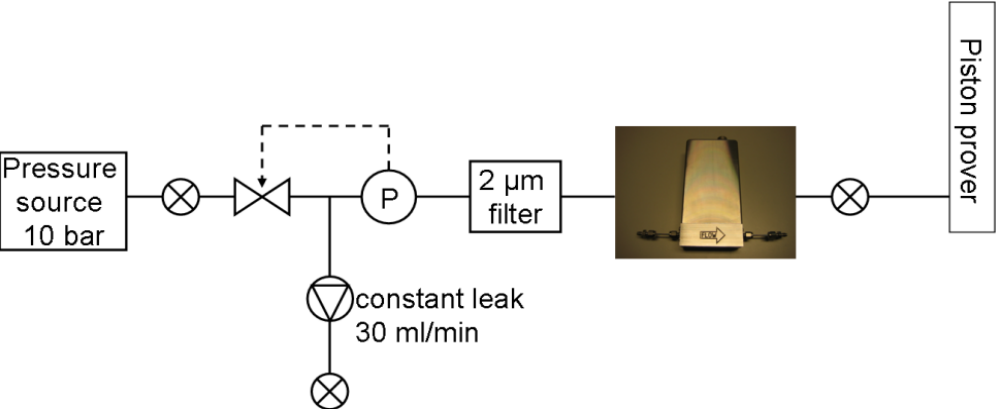
Figure 6. Schematic overview of the setup used for the air mass flow measurements. Air was pressurized at 10 bara. Pressure meter P controls the pressure before the Coriolis mass flow meter. A constant leak of 30 mL/min is necessary for the valve to operate reliably. The filter is placed in front of the Coriolis mass flow meter to prevent clogging. A piston prover is used as a